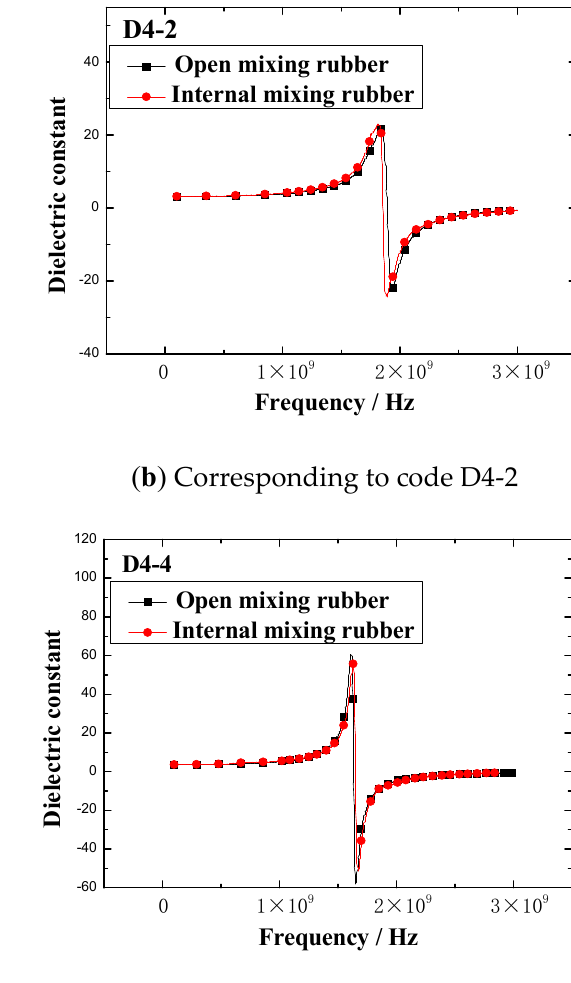
lectric constant with the frequency is consistent. At lower frequencies, the dielectric con-